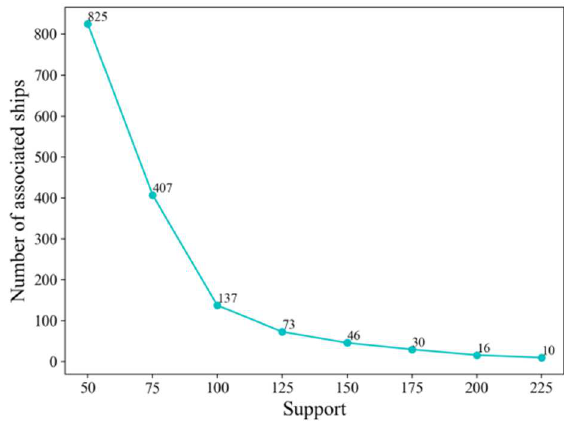
Figure 5. Degree of the support impact analysis.